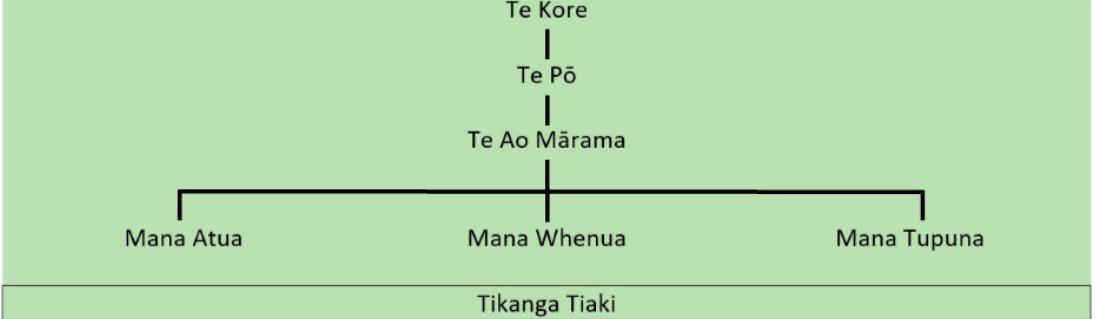
Figure 5. A whakapapa sequence indicating connections between a M ā ori view of the world, M ā ori thought and practices.